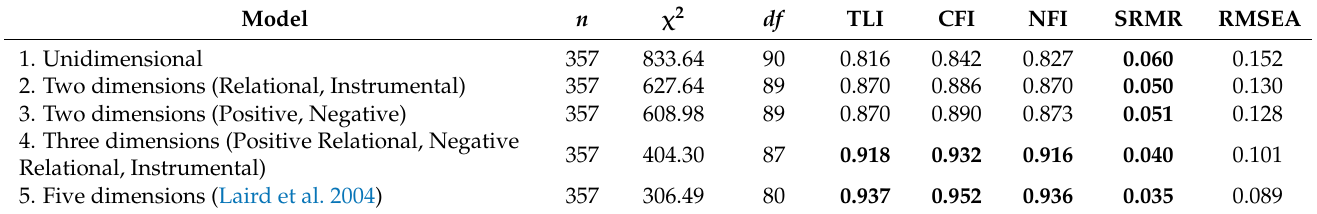
Table 2. Summary of Confirmatory Factor Analysis on the Multidimensional Prayer Inventory Scale.